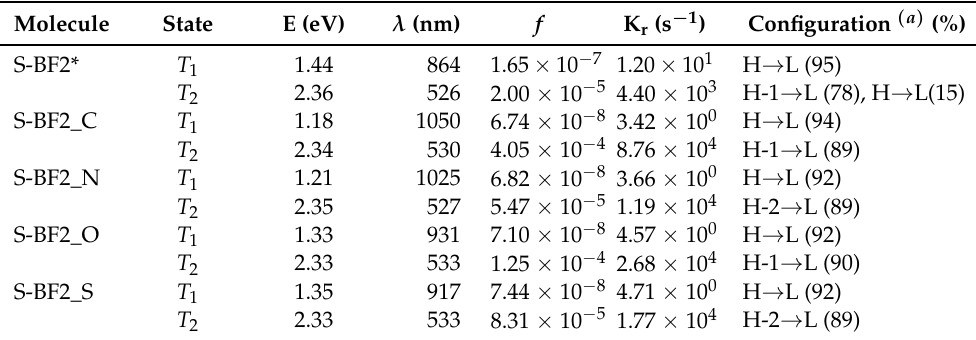
Table 4. Emission energies, wavelengths, oscillator strengths, radiative rates, and electron configura- tions of the new molecules in CH 2 Cl 2